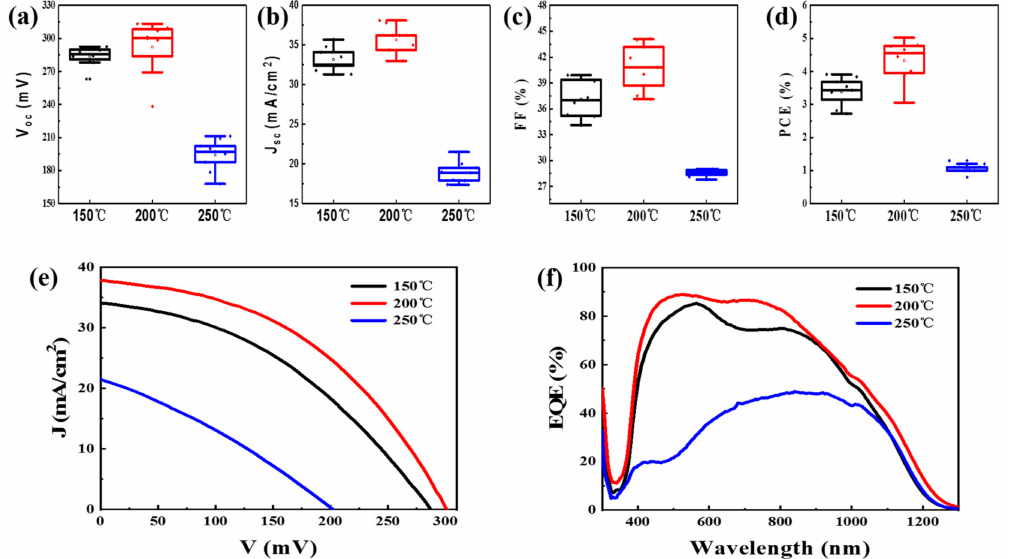
Figure 5. The statistical photovoltaic performance of the flexile CZTSSe solar cells based on 100 nm ZnO films produced under different annealing temperatures: ( a ) V oc , ( b ) J sc , ( c ) FF and ( d ) PCE. ( e ) The EQE and ( f ) J-V curves of the champion flexile CZTSSe/ZnO solar